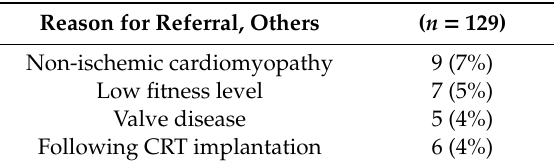
Table A1. Specifying “Other” reasons for referral.